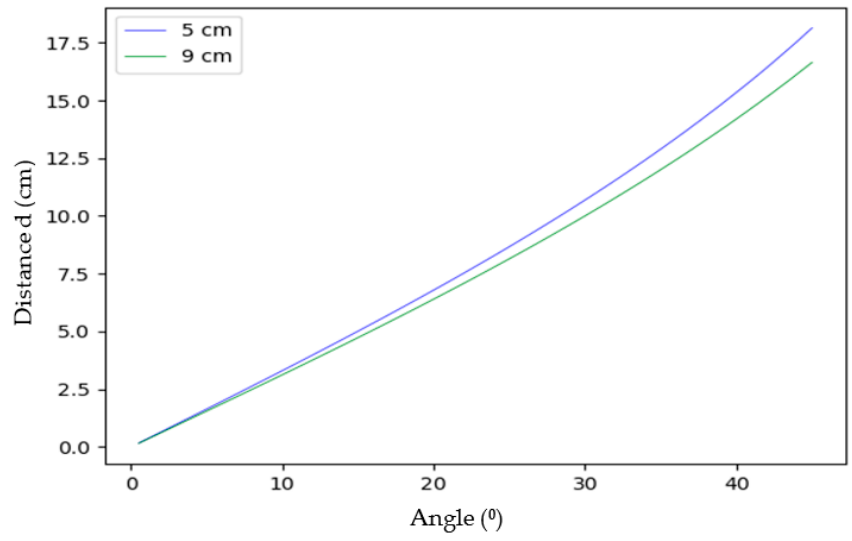
12 of 17 Figure 4. Water classification sensor flowchart. Before elaborating on the machine learning (ML) model results, it is important that we graphically show the data sets and some visible impact of concentration, temperature, wavelengths, and their correlation with changes in the index of refraction or distance d. The following key point is significant because it demonstrates changes in the input layer